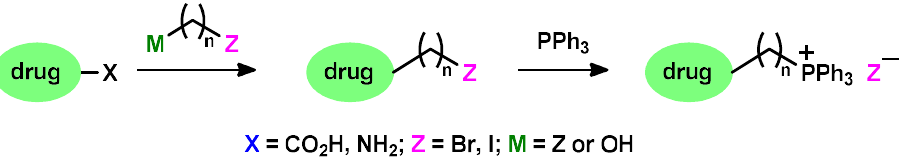
Scheme 2. The method of obtaining phosphonium salts by alkylation of triphenylphosphine with halogen-alkyl derivatives of halogen-alkyl derivatives of drugs.